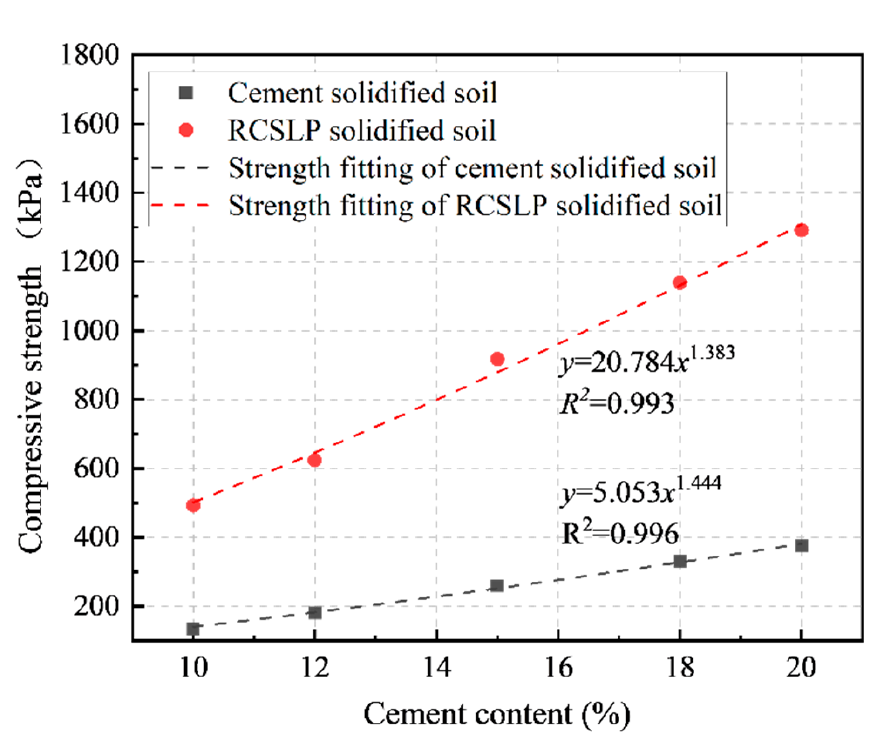
Figure 6. Compressive strength variation of solidified soil with cement content. The relationship between the compressive strength of RCSLP solidified soil R 2